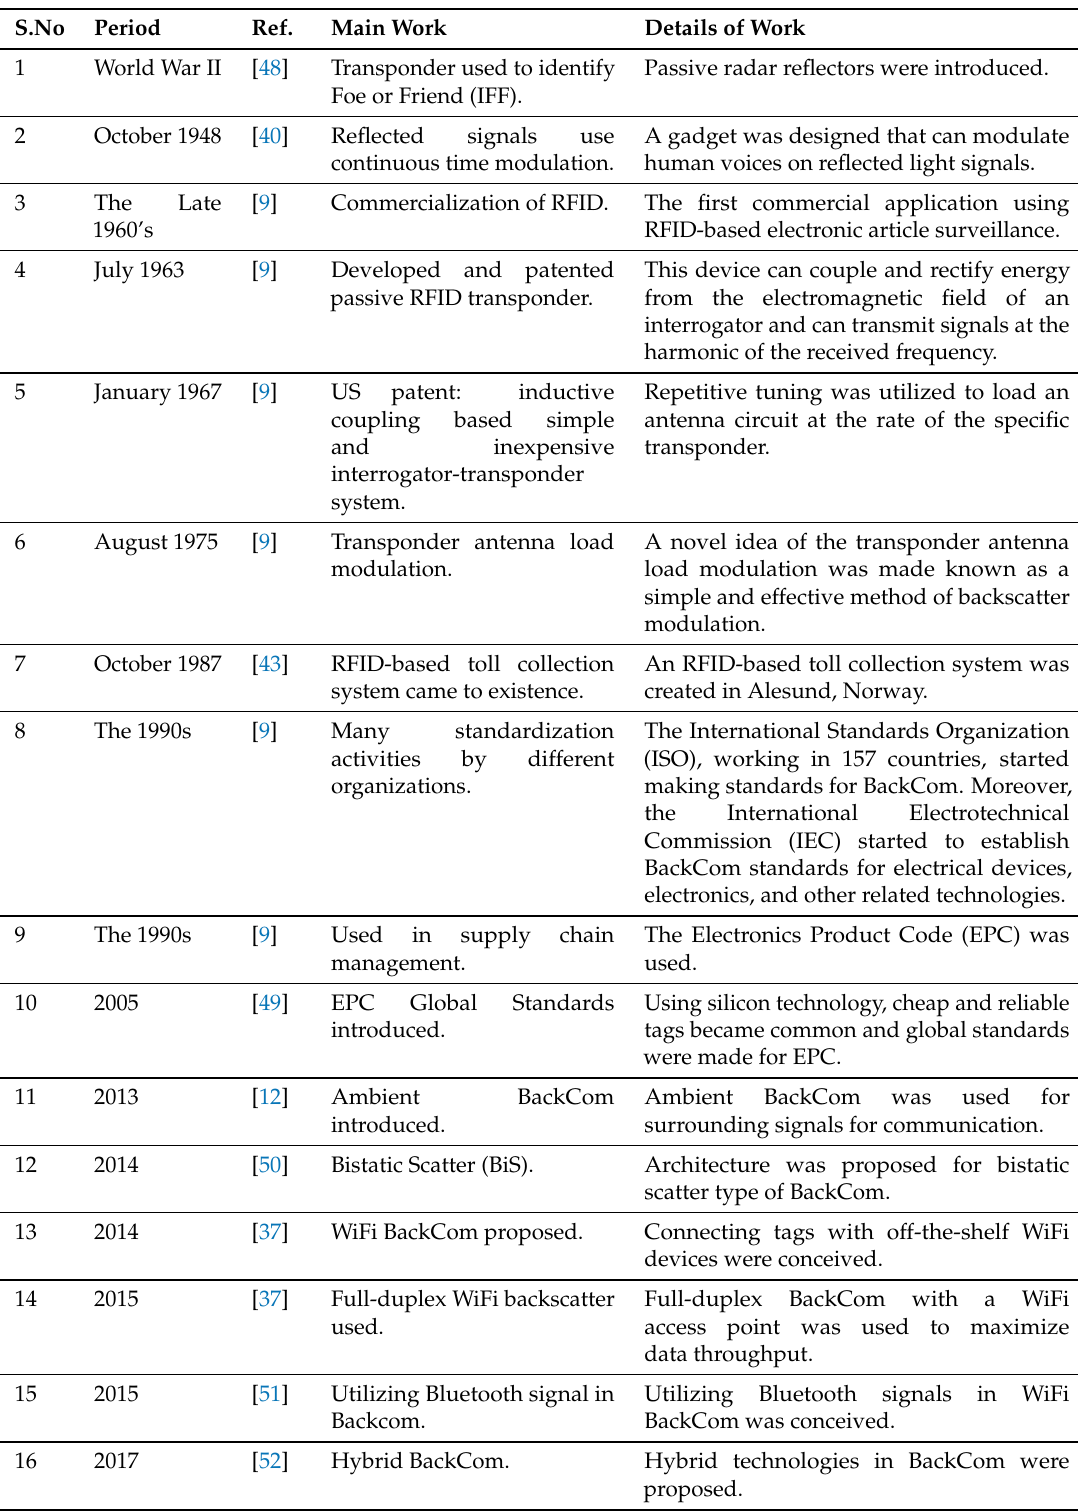
Table 2. Evolution of